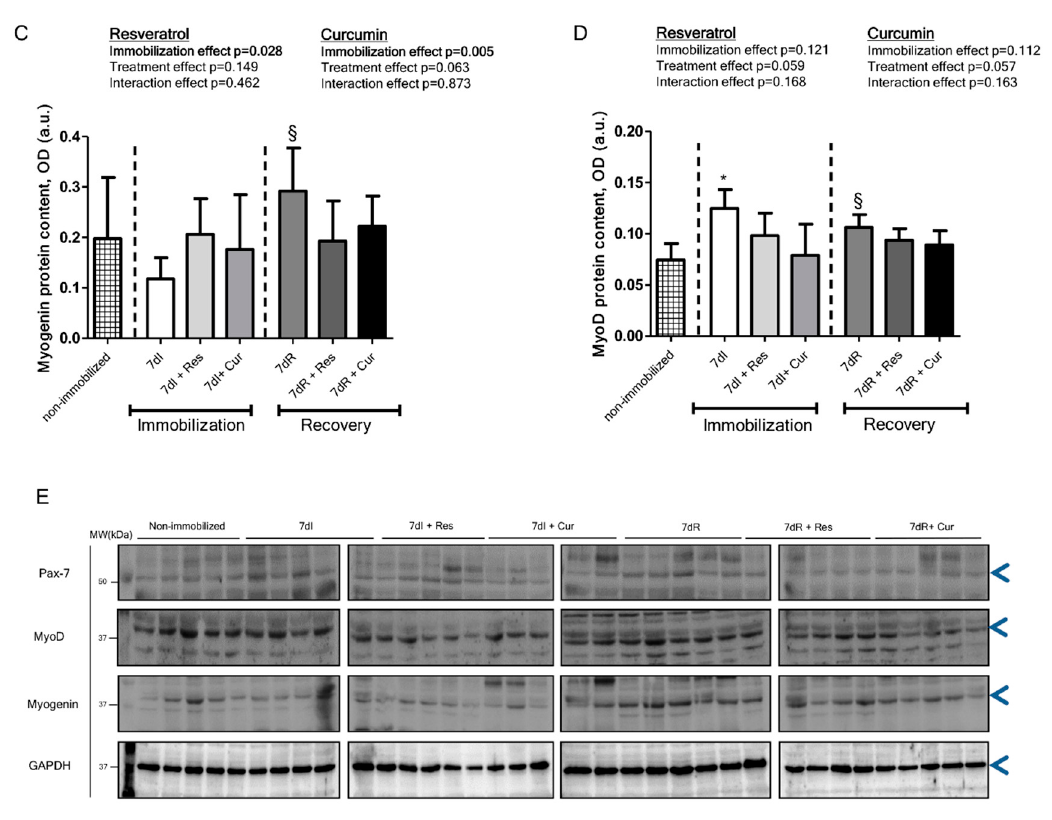
Figure 6. ( A ) Mean values and standard deviation of gene expression of Ki67 in the gastrocnemius muscle of the different study groups of mice. Definition of abbreviations: Ki67, cell proliferation Ki-67; mRNA, messenger ribonucleic acid; a.u., arbitrary units; I, immobilization; R, recovery; Res, resveratrol; Cur, curcumin. Statistical significance is represented as follows: §, p < 0.05 between the 7dI and 7dR groups of animals. The effect of immobilization and treatment and interaction effects are also indicated as actual p values for each variable. ( B ) Mean values and standard deviation of Pax-7 protein content, as measured by optical densities in arbitrary units (OD, a.u.). Definition of abbreviations: OD, optical densities; a.u., arbitrary units; Pax-7, paired box-7; I, immobilization; R, recovery; Res, resveratrol; Cur, curcumin. Statistical significance is represented as follows: *, p < 0.05 between the 7dI animals and non-immobilized mice; §, p < 0.05 between the 7dI and 7dR groups of animals. The effect of immobilization and treatment and interaction effects are also indicated as actual p values for each variable. ( C ) Mean values and standard deviation of myogenin protein content, as measured by optical densities in arbitrary units (OD, a.u.). Definition of abbreviations: OD, optical densities; a.u., arbitrary units; I, immobilization; R, recovery; Res, resveratrol; Cur, curcumin. Statistical significance is represented as follows: §, p < 0.05 between the 7dI and 7dR groups of animals. The effect of immobilization and treatment and interaction effects are also indicated as actual p values for each variable. ( D ) Mean values and standard deviation of MyoD protein content, as measured by optical densities in arbitrary units (OD, a.u.). Definition of abbreviations: OD, optical densities; a.u., arbitrary units; MyoD, myogenic differentiation 1; I, immobilization; R, recovery; Res, resveratrol; Cur, curcumin. Statistical significance is represented as follows: *, p < 0.05 between 7dI animals and non-immobilized mice; §, p < 0.05 between the 7dI and 7dR groups of animals. The effect of immobilization and treatment and interaction effects are also indicated as actual p values for each variable. ( E ) Representative immunoblots of Pax-7, MyoD, myogenin and GAPDH proteins in the gastrocnemius muscle of all study groups of mice. Arrowheads indicate the corresponding analyzed band. Definition of abbreviations: Pax-7, paired box-7; MyoD, myogenic differentiation 1; GAPDH, glyceraldehyde-3-phosphate dehydrogenase; MW, molecular weight; kDa, kilodalton; I, immobilization; R, recovery; Res, resveratrol, Cur, curcumin.